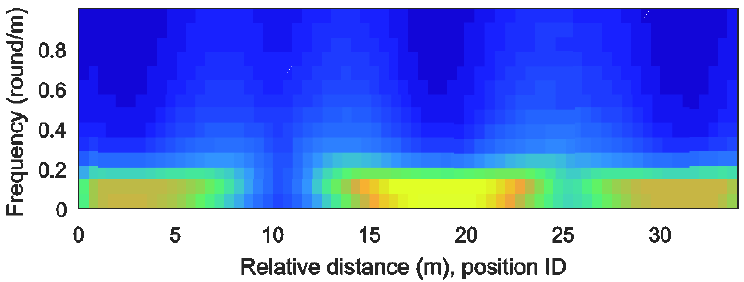
Figure 9. Spectrogram of the estimated road profile.